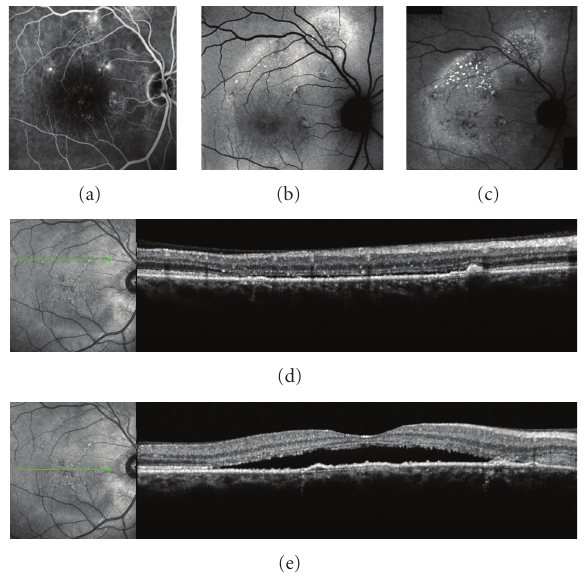
Figure 3: Patient with 18 months of history of CSC in the right eye. (a) dots spots of leakage in the angiography; (b) standard FAF, showing di ff use superior hyperFAF; (c) NIA, showing three hypofluorescent spots around the macula, some of them corre- sponding exactly with the PEDs in (d) and (e); (d) and (e) SD-OCT exhibiting the PEDs and neurosensorial retinal